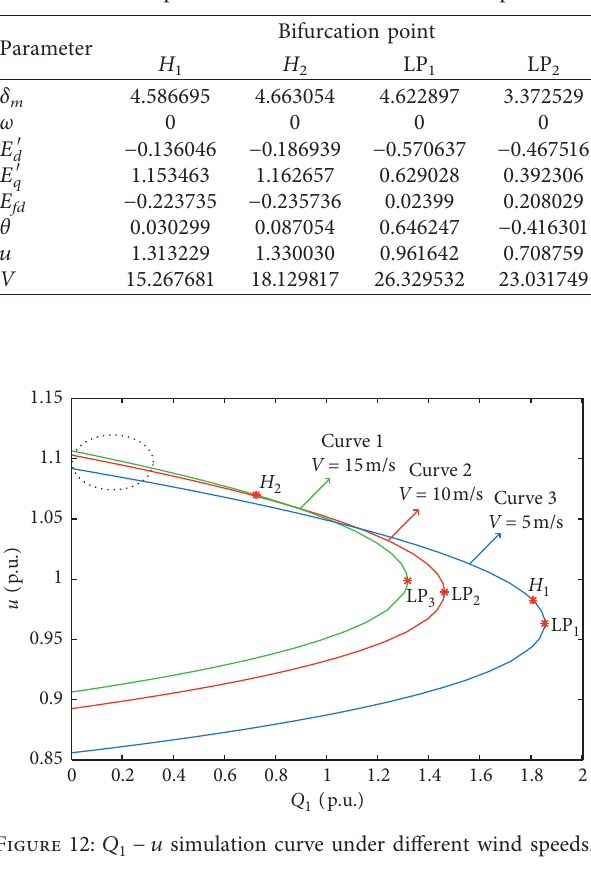
Figure 10: u − t curve of the system after small interference.